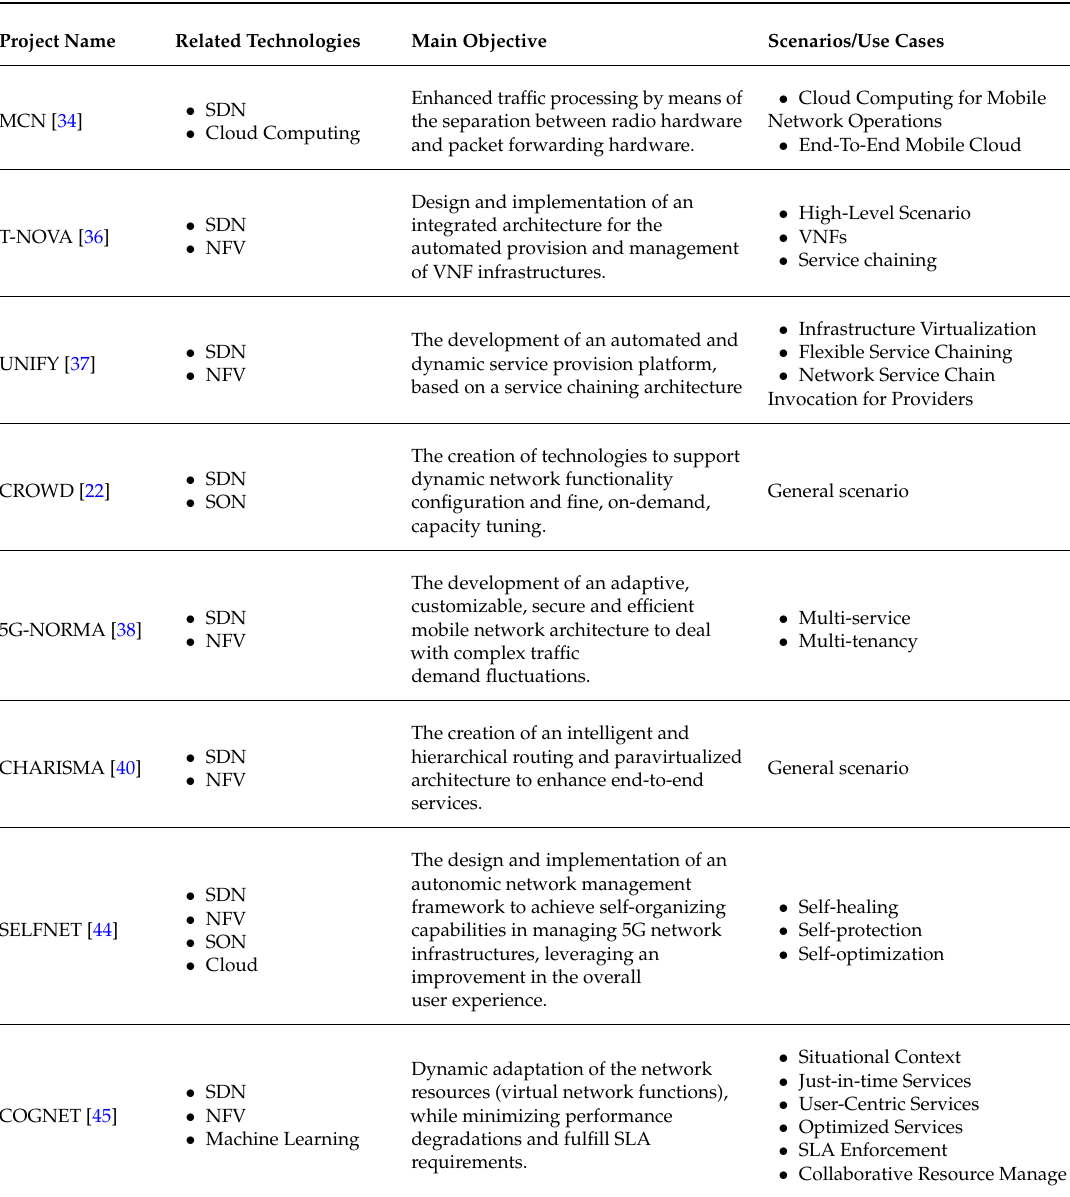
Table 1. Research Projects in Mobile